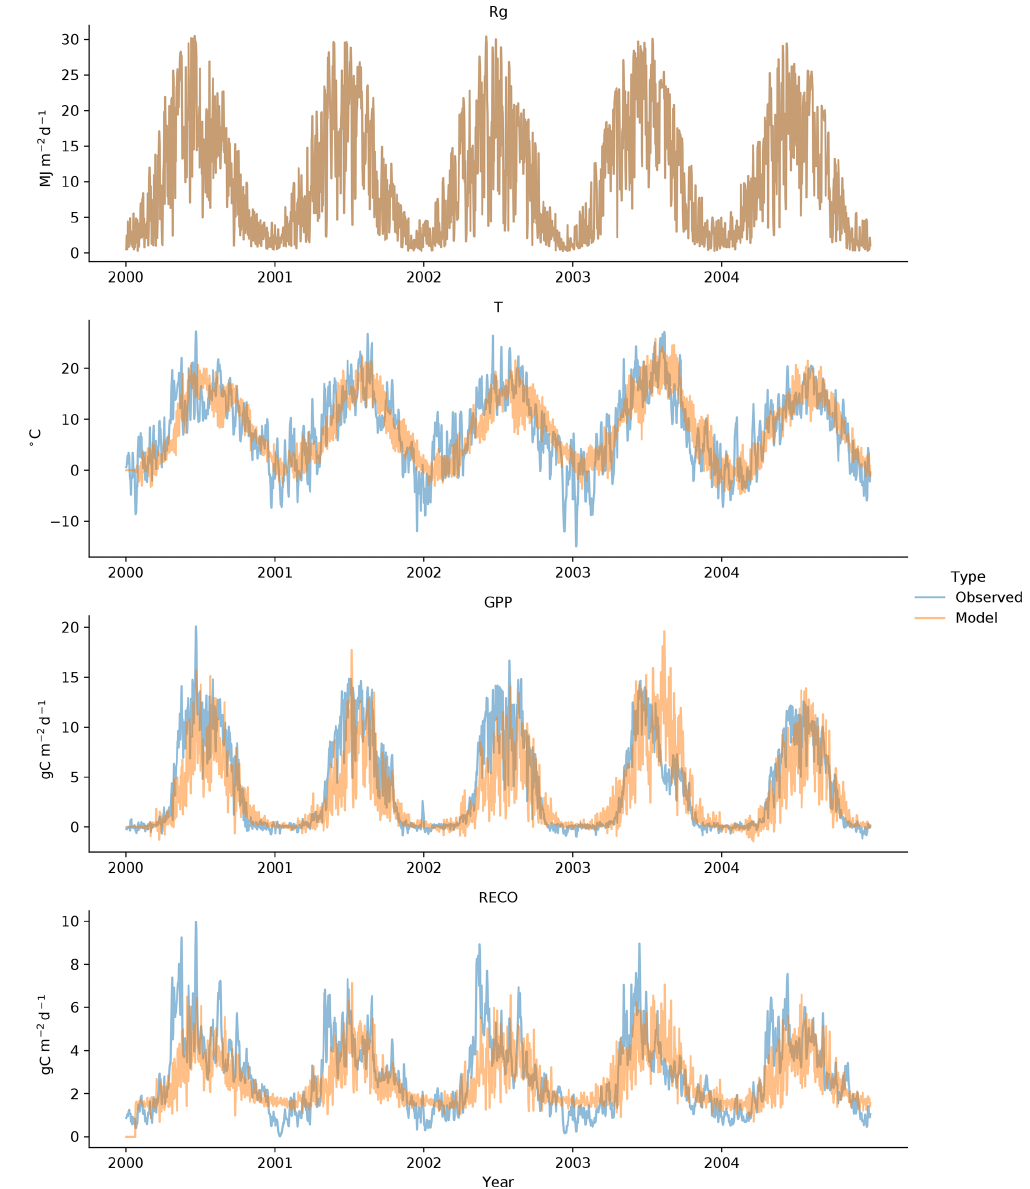
Figure A5. Observed (blue) and test model (orange) time series for the Hainich Fluxnet site. The model data were produced with het- eroscedastic